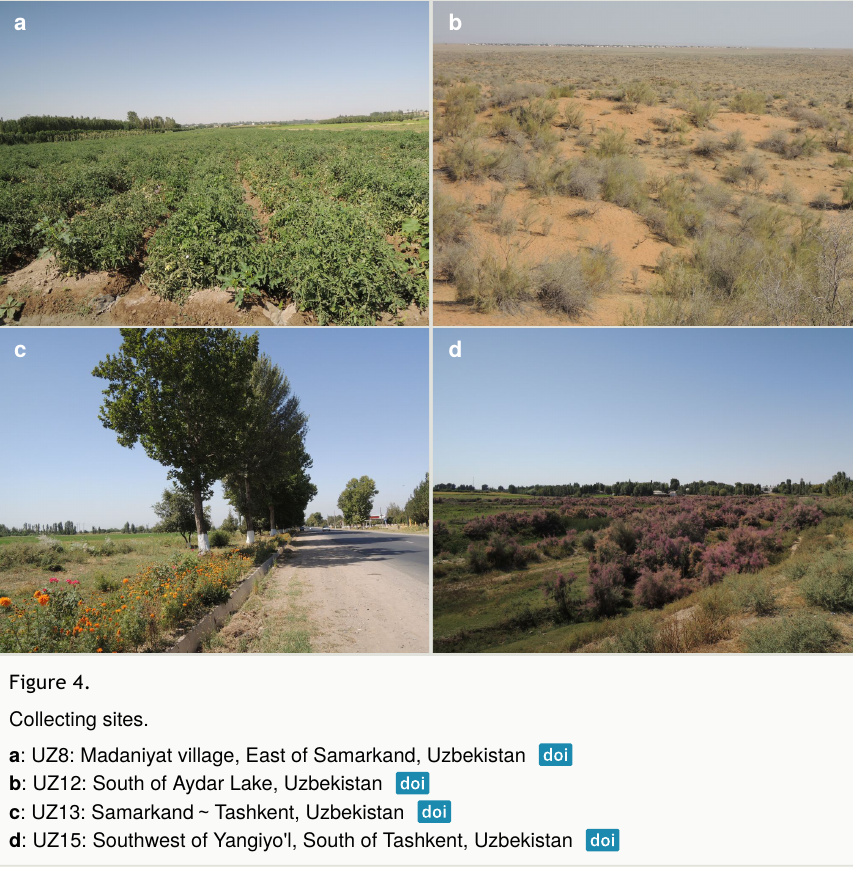
Figure 4. Collecting